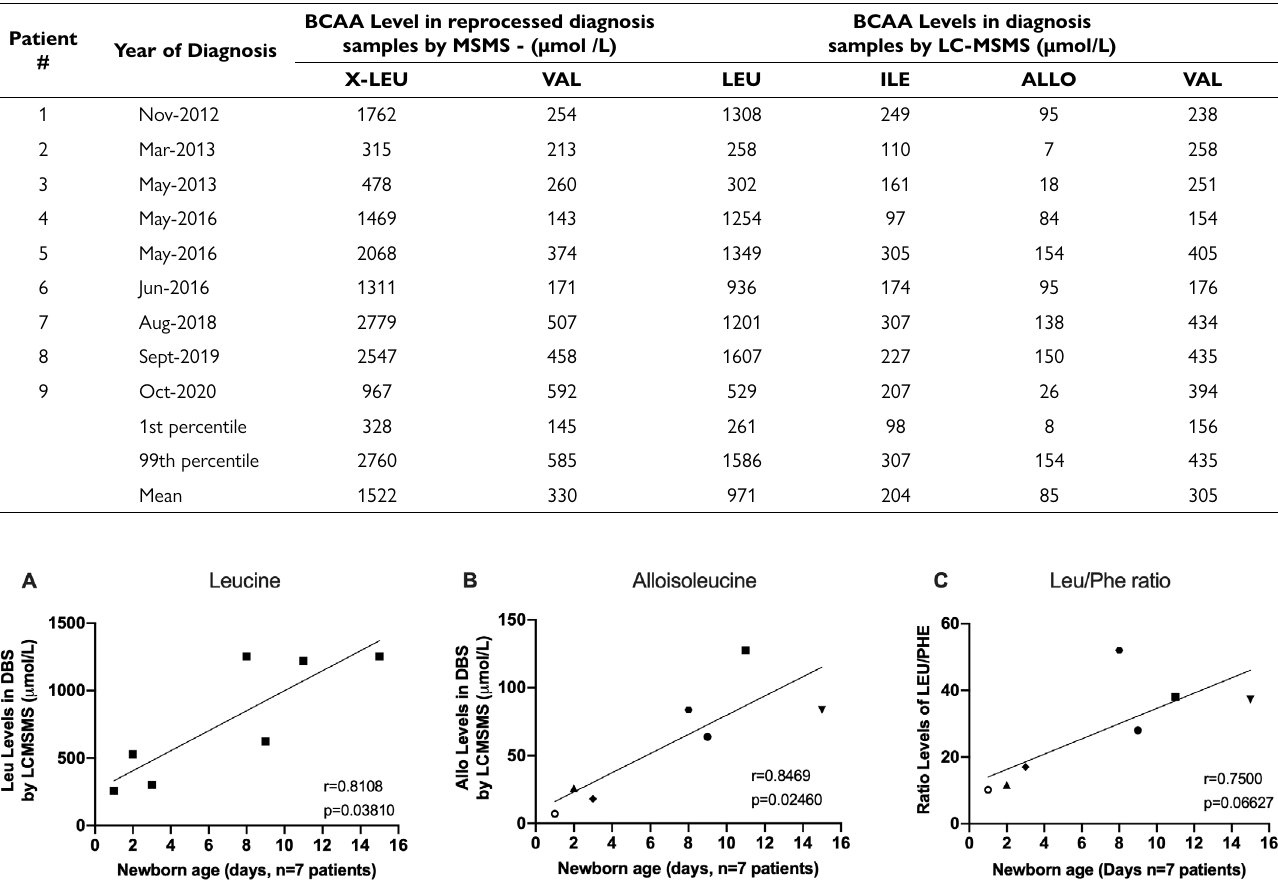
Figure 1. Correlation of Leu and Allo blood levels and Leu/Phe ratio with age. Analysis of Leu, Allo and Leu/Phe ratio of each dried blood spot sample of diagnosed MSUD patients was correlated with newborn age. Each point represents one patient; in total, data from seven patients are displayed (r: Spearman rho, p value <0.05, for Leu and